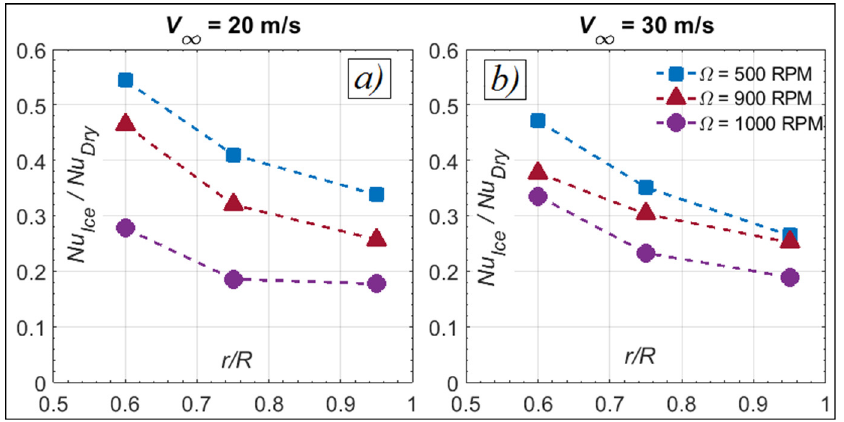
Figure 16. Ratios of the Calculated Nu Ice to the Nu Dry for the De-Icing Tests at T ∝ ≈ 265.65 K and ( a ) V ∝ = 20 m/s and ( b ) V ∝ = 30 m/s.